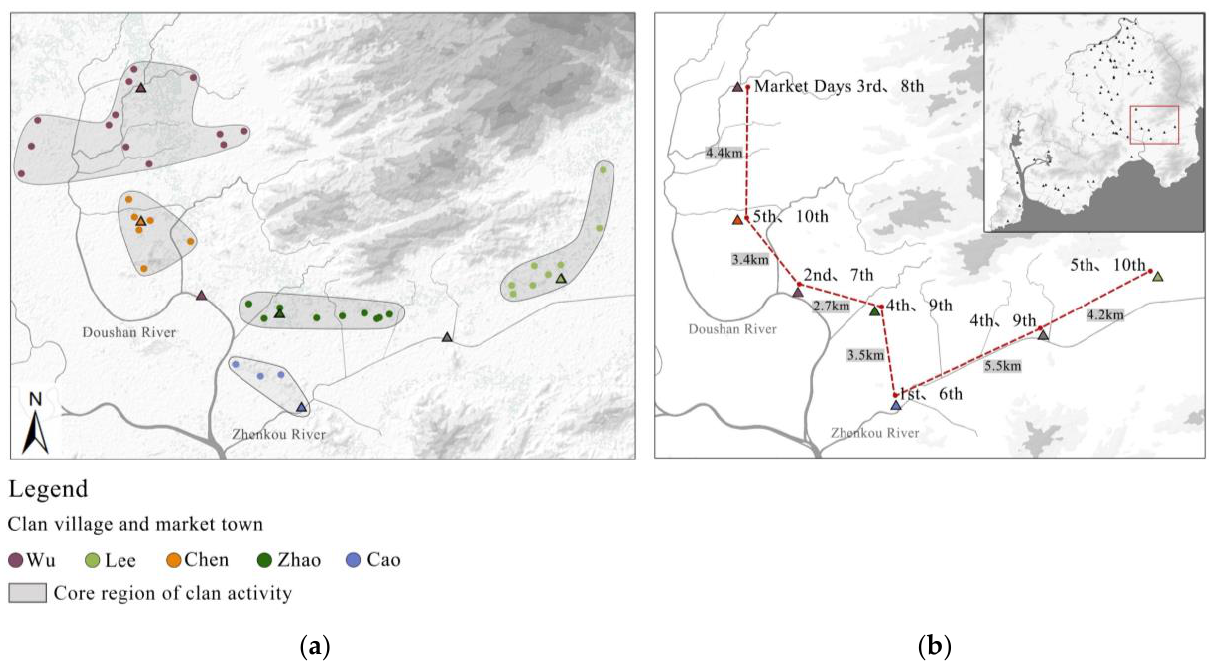
Figure 6. Diagram of the region between the Duanfen River and the Datong River. The different color triangles represent different clan market towns, and the different color dots represent different clan villages. ( a ) Illustrates the different clans' territories maintain normal intervals; ( b ) This figure illustrates the spatial and temporal distribution of normal intervals between market towns.